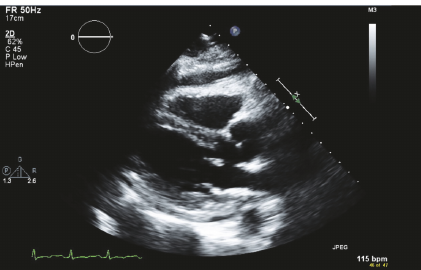
Figure 1: Parasternal long view of the pericardial effusion on transthoracic echocardiogram.